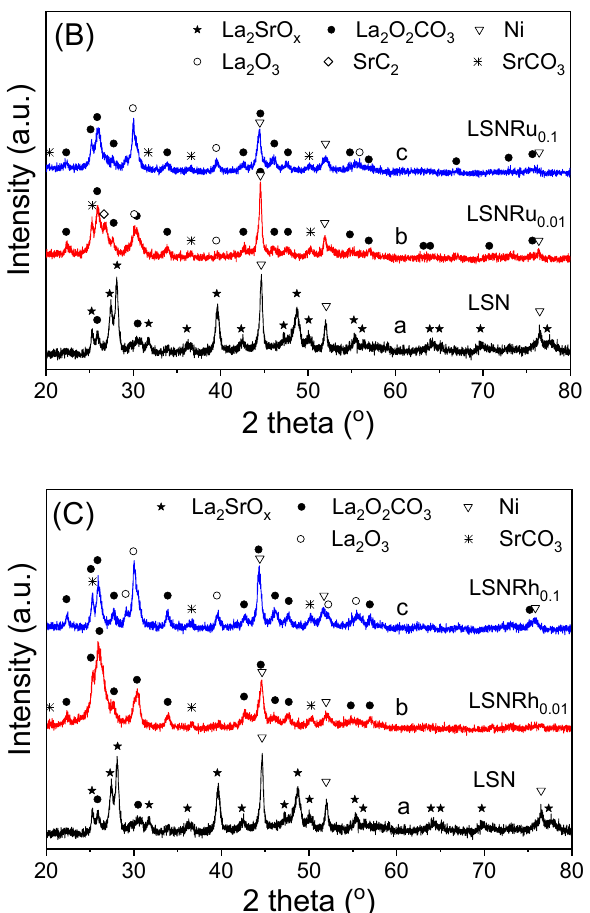
Figure 6. X-ray diffraction patterns obtained for the ( A ) LNRu x , ( B ) LSNRu x , and ( C ) LSNRh x catalyst samples following exposure to reaction conditions.